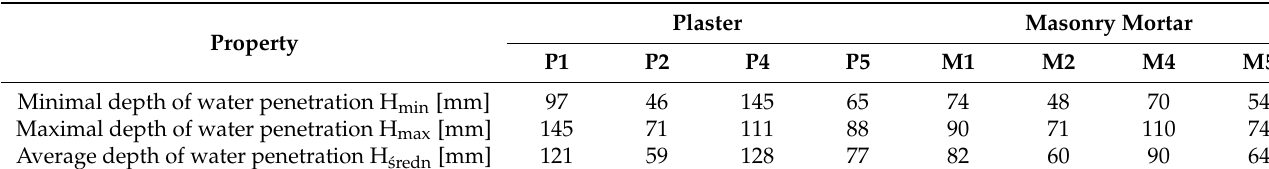
Table 8. Depth of water penetration under pressure.